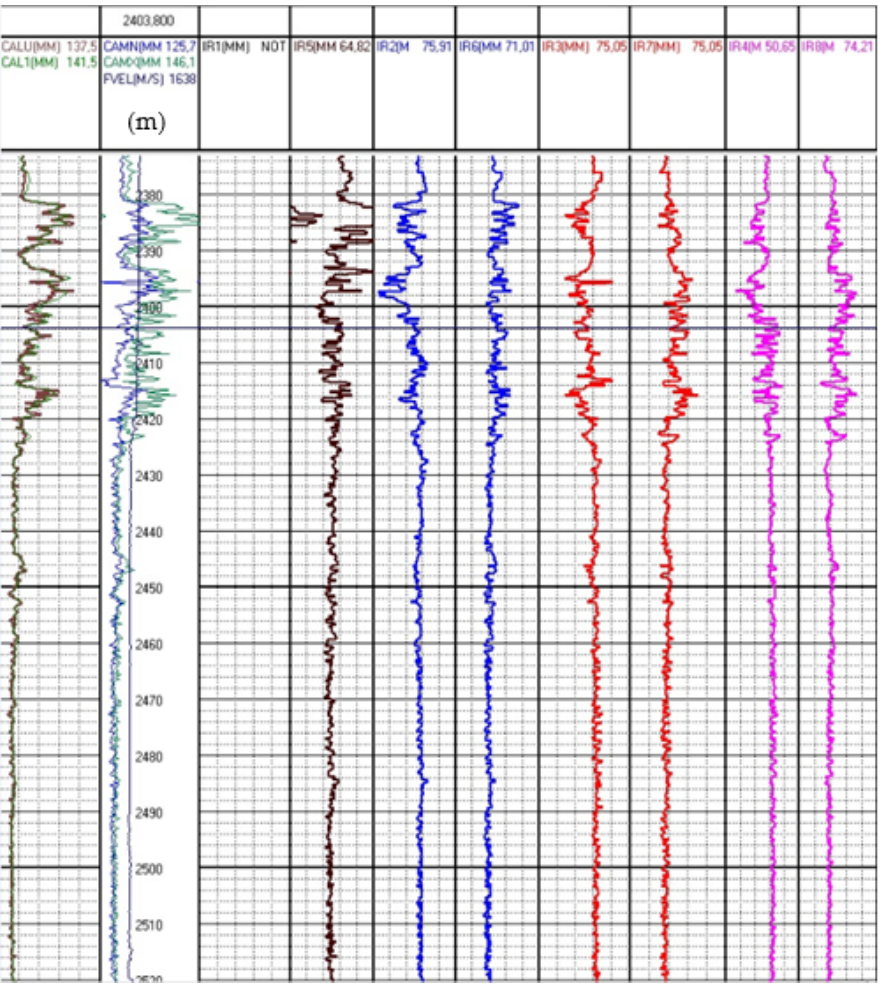
Figure 5. Radius and diameter curves.